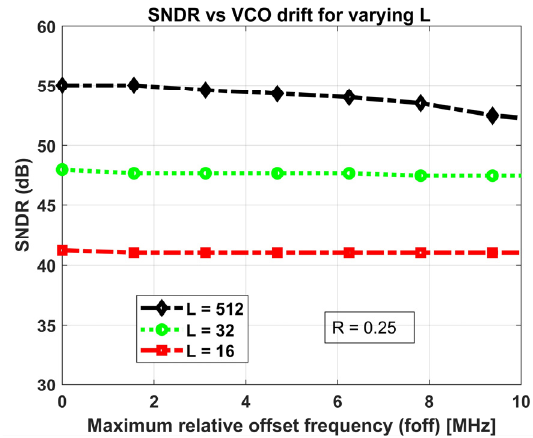
Figure 12. Variation in the measured SNDR of the output with the magnitude of maximum relative offset frequency of the two VCOs for varying L .